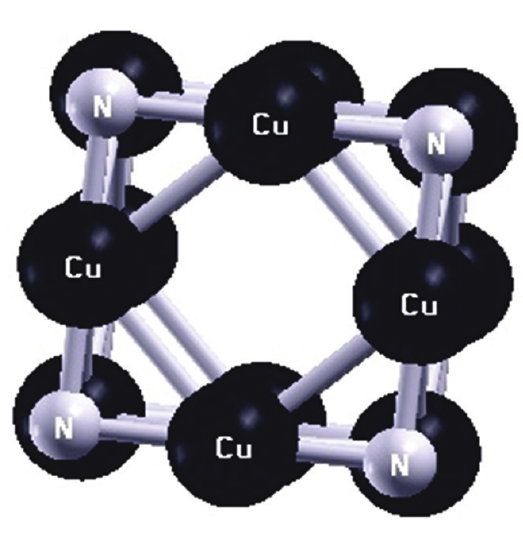
Figure 2. Total energy versus the atomic volume for cubic Cu